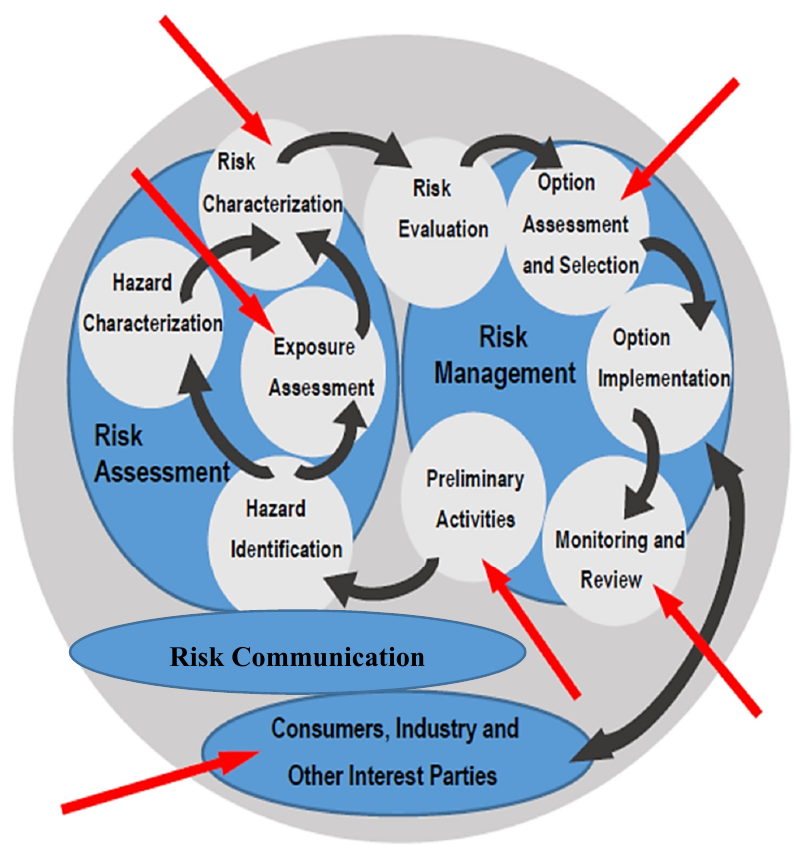
Figure 1. Integration of risk evaluation, communication and management by the EFSA.